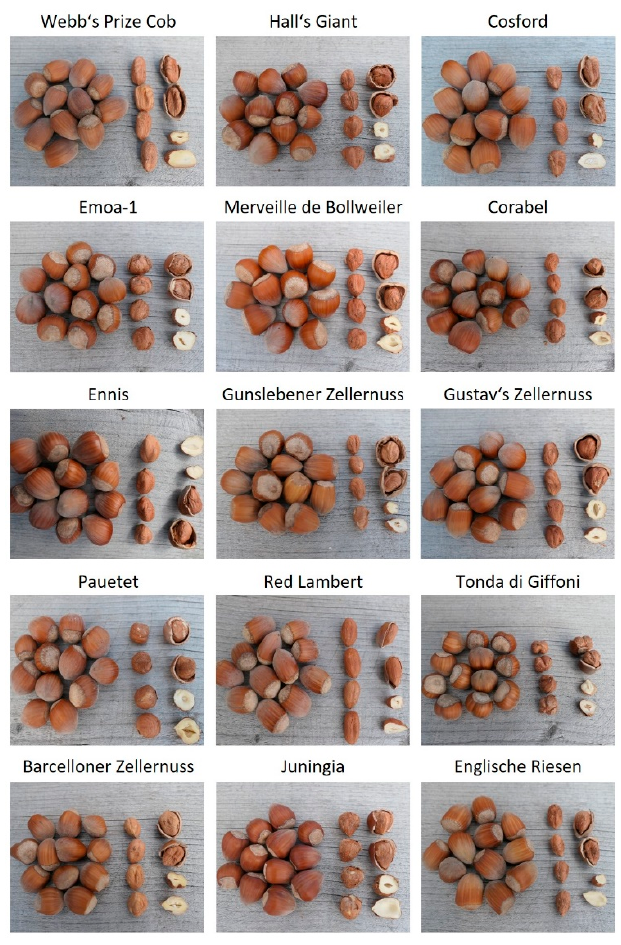
Figure 1. Representative exemplary pictures of the hazelnut cultivars studied.